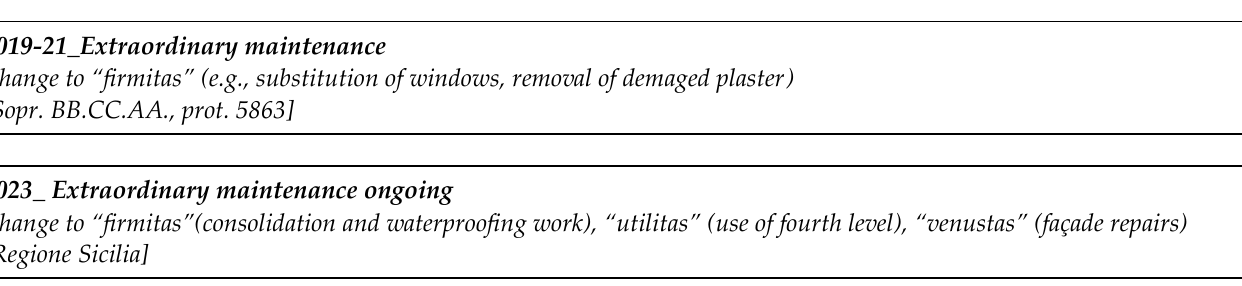
Figure 8. The variation of the Vitruvian triad of the former Fascist House over time.